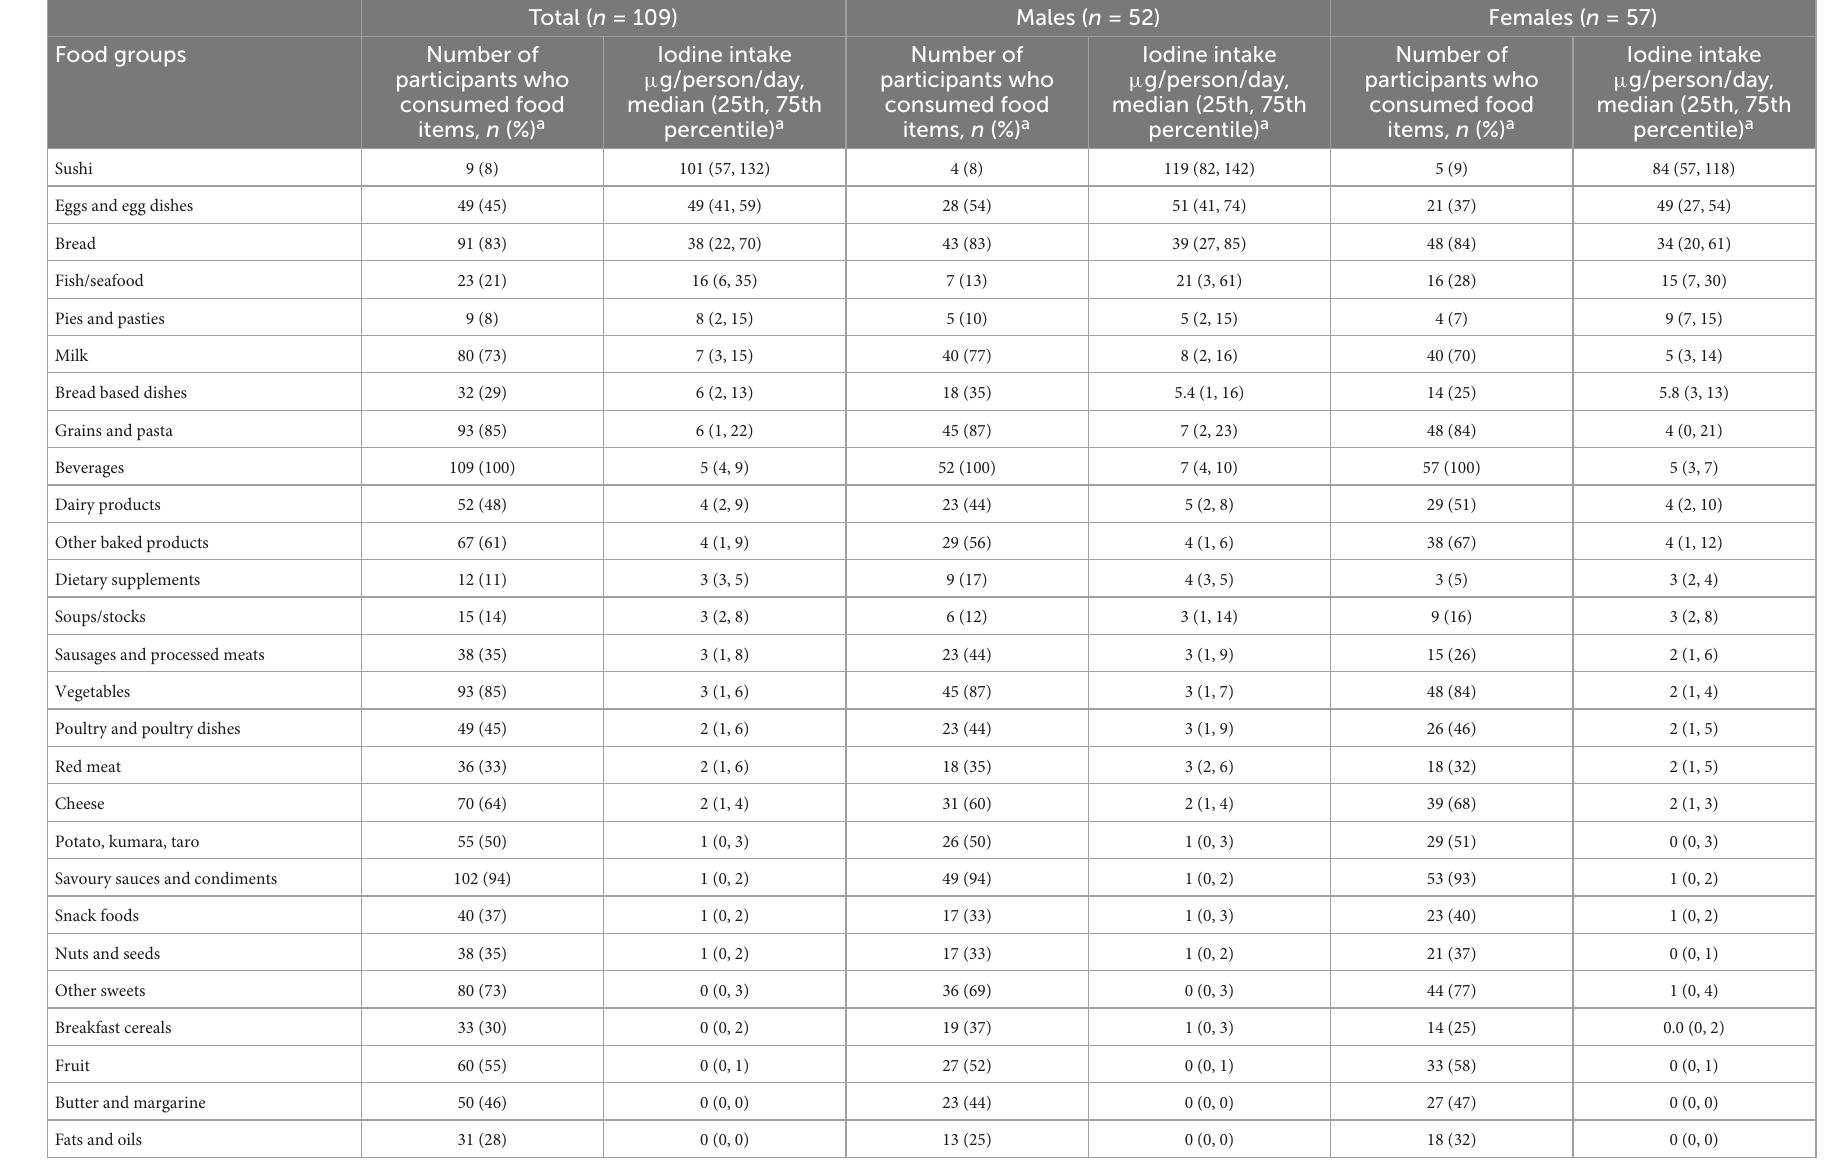
TABLE 5 Number of participants who consumed food items in each food group and median iodine intake ( µ g/person/day) of participants who consumed food items in each food group, in total and by gender. Total ( n = 109) Food